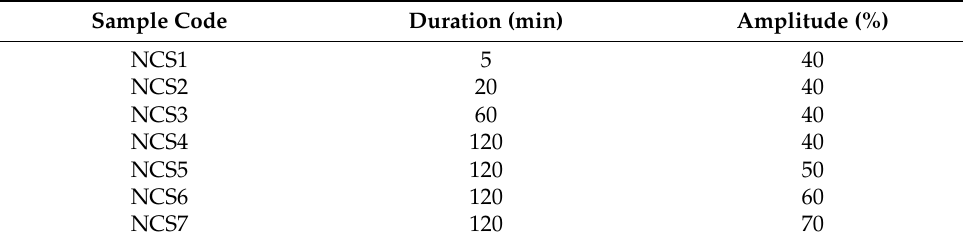
Table 1. Sample codes based on duration and amplitude